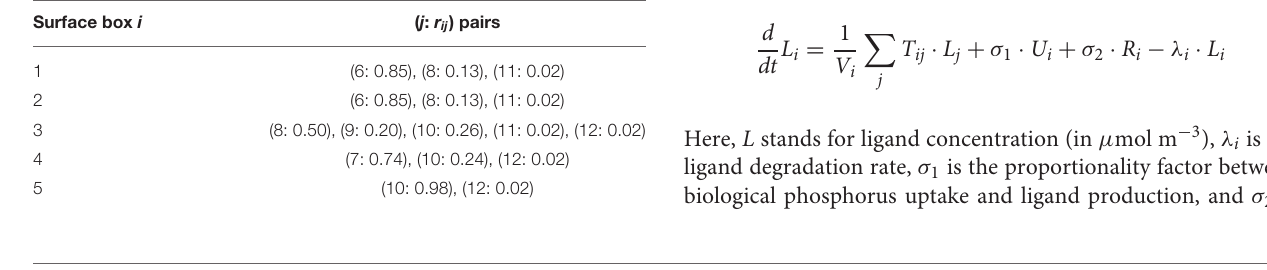
TABLE 4 | Biogeochemical parameters of the model; where more than one value appears in a row, the first is for the constant-ligand case (CL), the second and third for the case with one DOC-type ligand (1L and 1H), and the other two for the two different cases with both a DOC-like and a siderophore-like ligand (2L and 2H).